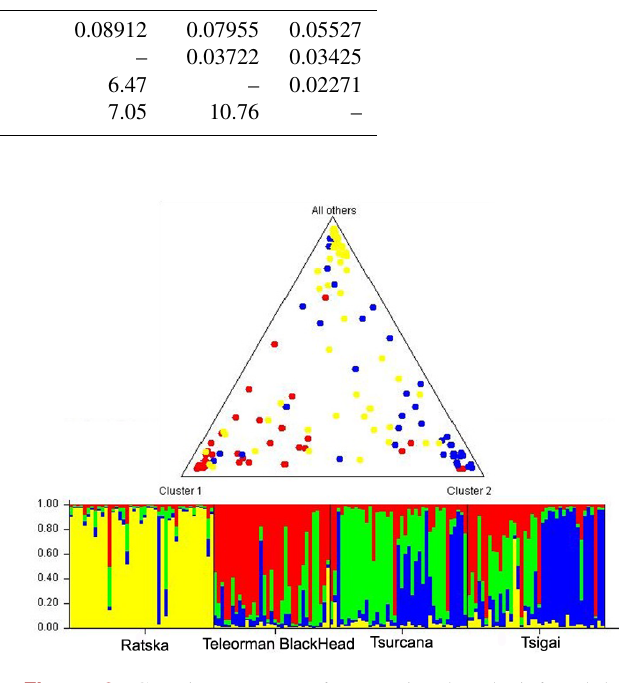
Figure 3. Genetic structure of Romanian breeds inferred by Bayesian analysis at K = 4 using STRUCTURE program. Ratska – yellow; Teleorman Blackhead – red; Tsurcana – green; Tsigai – blue. The colored bar plots show the assignment of individual ac- cording to Q values. Triangle plot displays average admixture ac- cording of these four